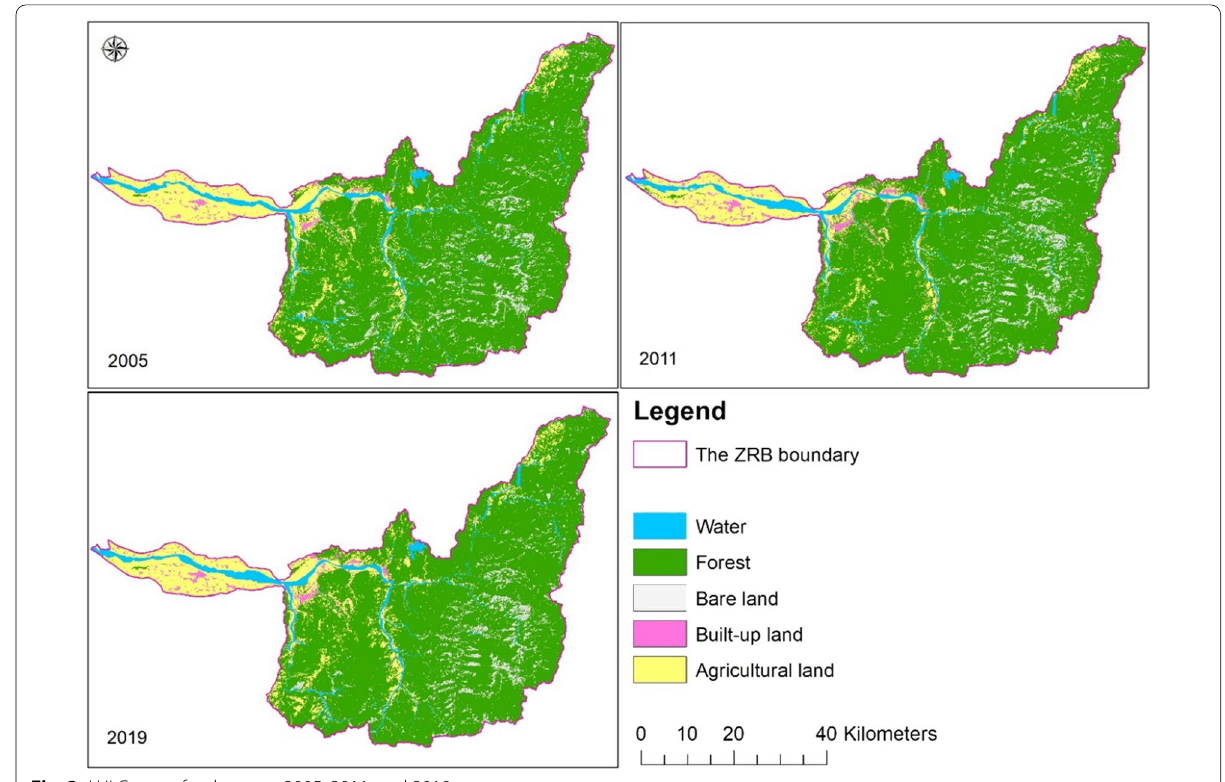
Fig. 3 LULC maps for the years 2005, 2011, and 2019